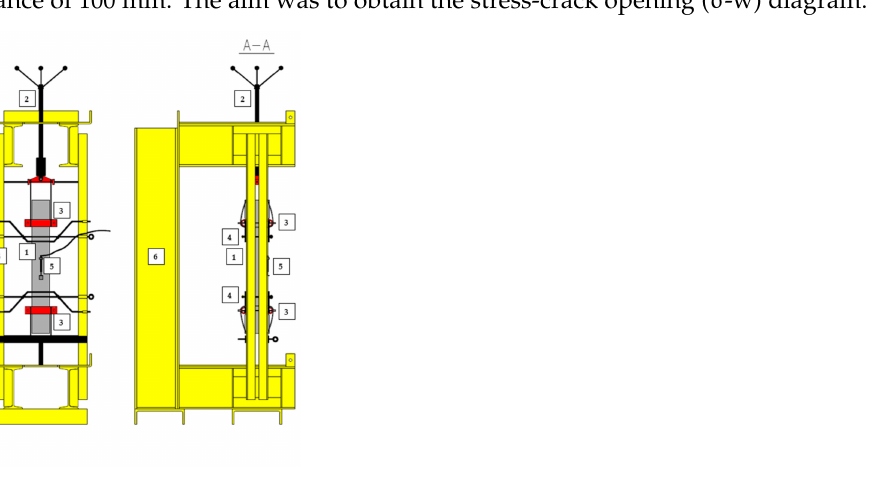
Figure 6. Set-up for uniaxial tensile test: 1-sample; 2—manual load application; 3—grip; 4—bar assembling to prevent falling down of the sample after failure; 5—LVDT to measure w; 6—rigid frame.